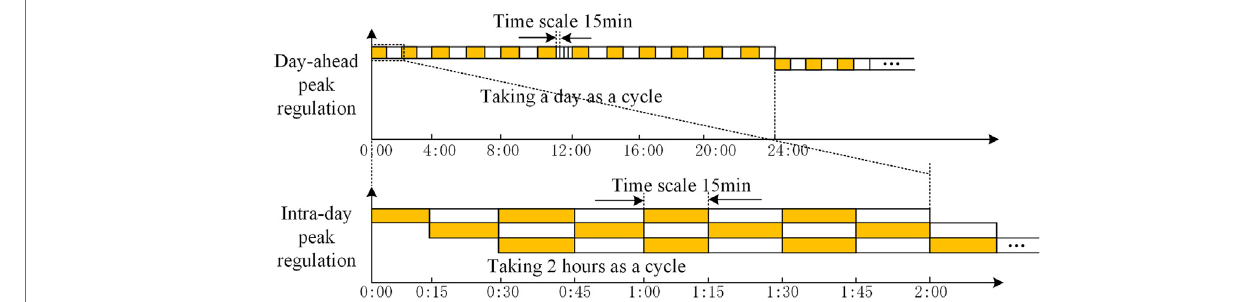
FIGURE 1 | Day-ahead and intra-day peak regulation timeline chart.